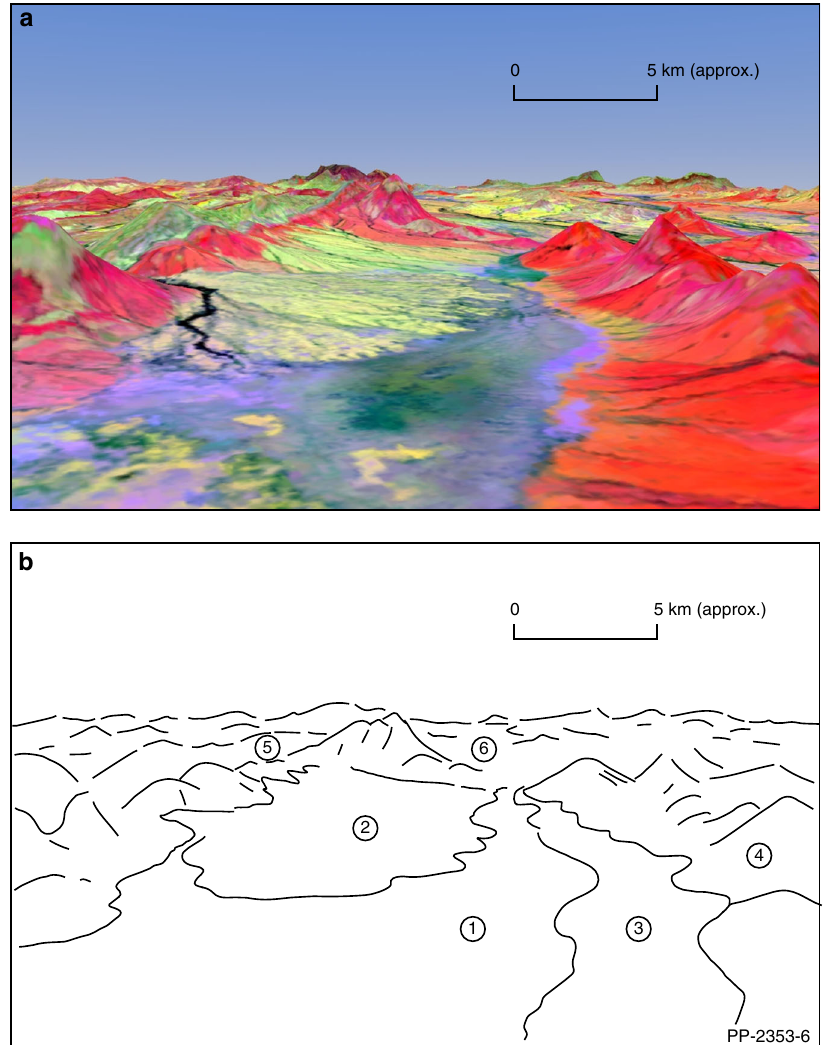
Fig. 8 Perspective view of a enhanced Barest Earth output showing variations in surface mineralogy. We used enhanced mineral mapping techniques to produce a thematic mineral map of the Australian continent using the Barest Earth mosaic, a subset of north central Western Australia is shown above ( a ). The second principal component of ratio bands NIR/RED and SWIR1/SWIR2 is used to highlight clays (red); the SWIR1/NIR ratio represents iron oxides (green) and the addition of BLUE and SWIR2 represents highly re fl ective materials, such as silica-rich bedrock or quartz sand. This is perspective draped over a digital elevation model of the region. Key features ( b ) include: (1) alluvial sands and clays, (2) colluvial sediments including iron gravels, sand and clay, (3) colluvial clays, (4) proterozoic mudstone and siltstone, (5) proterozoic dolerite and gabbro and (6) reworked lateritic colluvial gravels. Mineral enhanced 3-D perspective drape with clays in red; iron oxides in green and highly re fl ective materials like silica-rich bedrock or quartz sand in